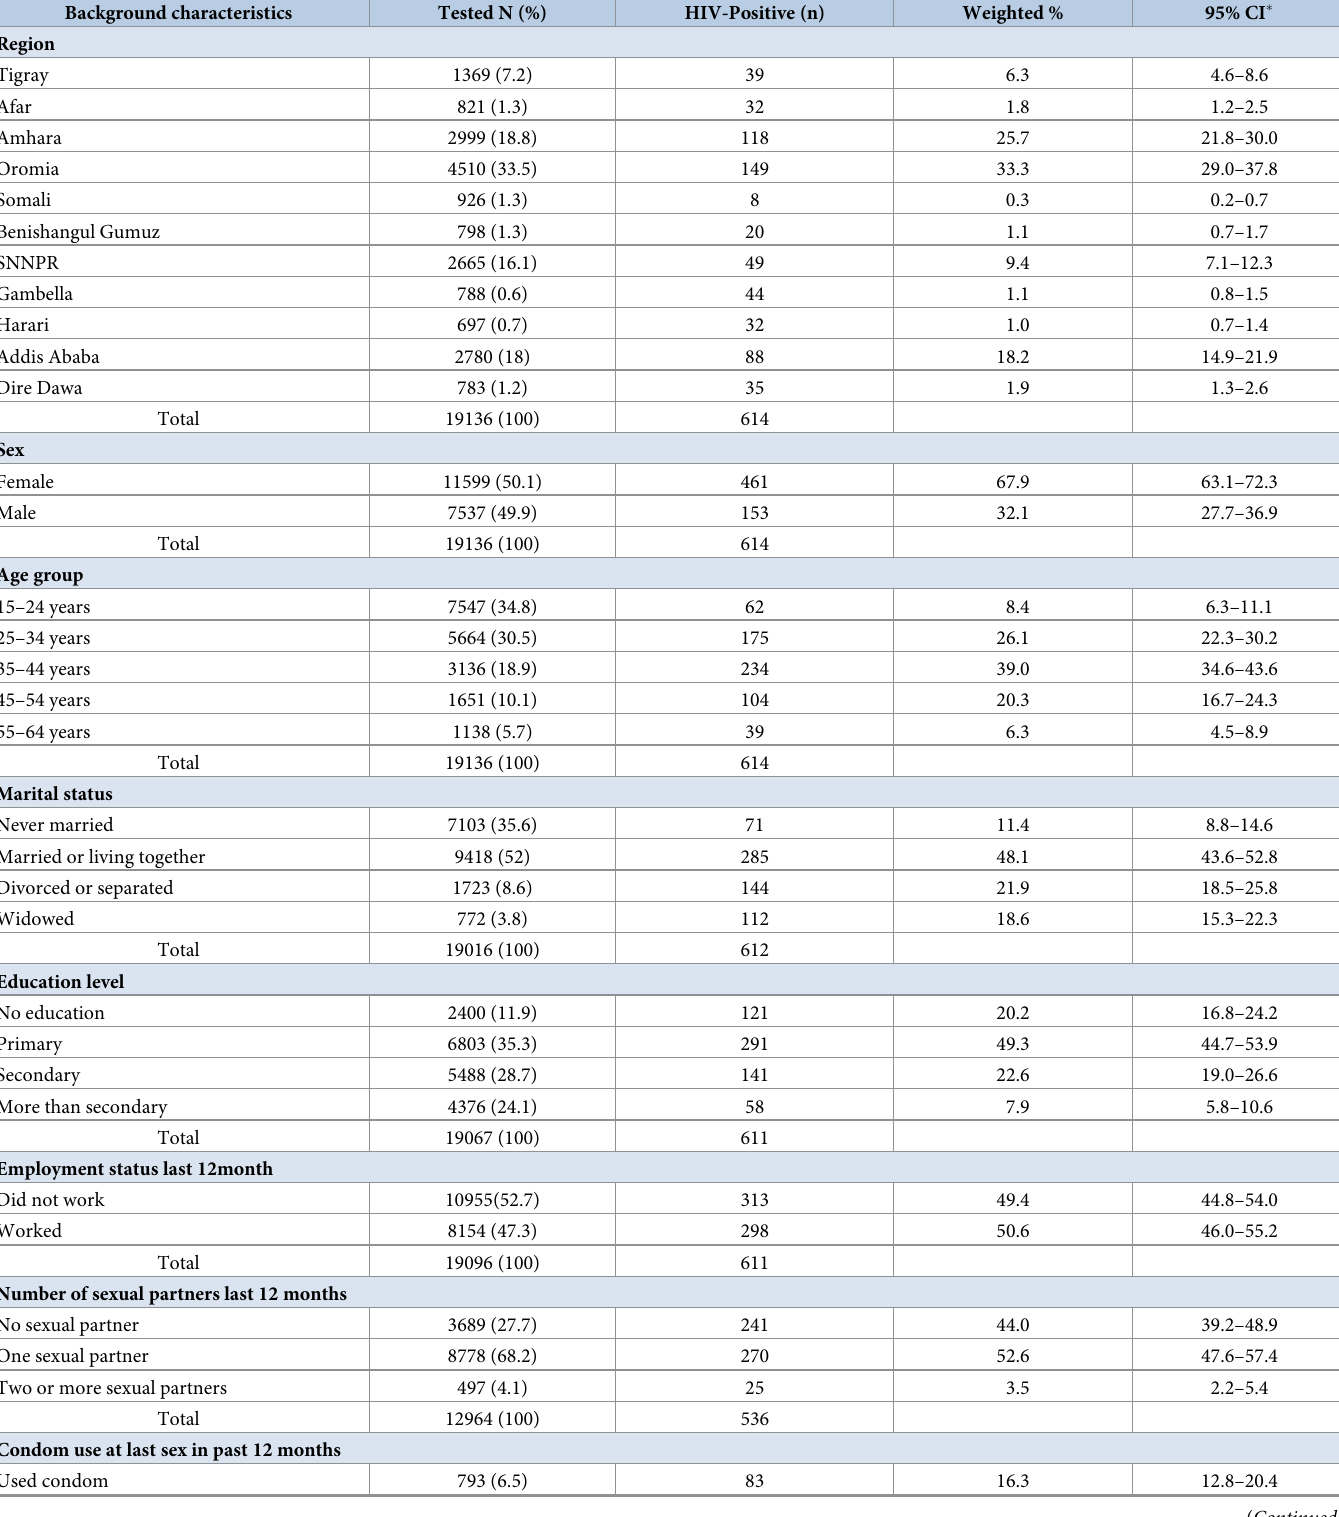
Table 1. Demographic, socioeconomic and behavioural characteristics of HIV-positive participants aged 15–64 in urban Ethiopia. Background